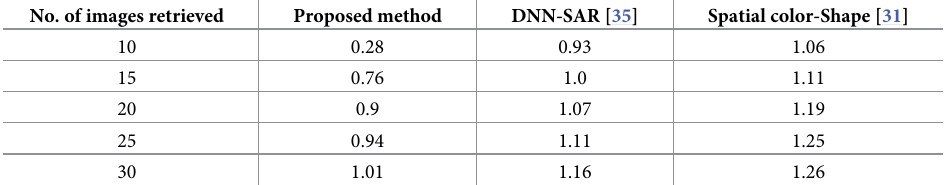
Table 8. Computational time (in seconds) of the proposed method and its comparative analysis with competitive methods of CBIR on the Caltech-256 dataset. No. of images